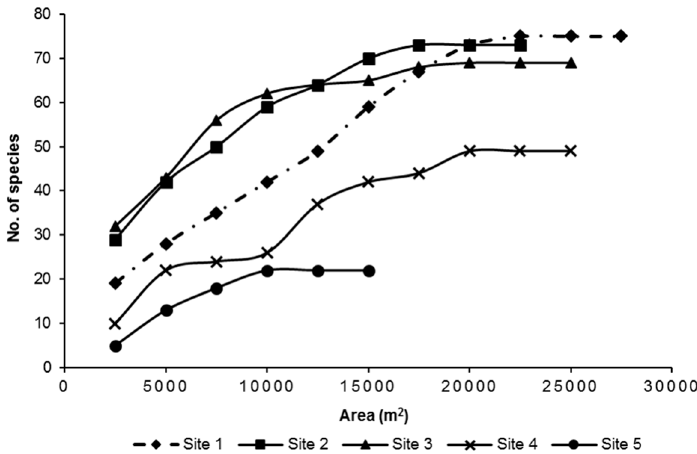
Figure 2. Species area curves of forests at the five study sites.